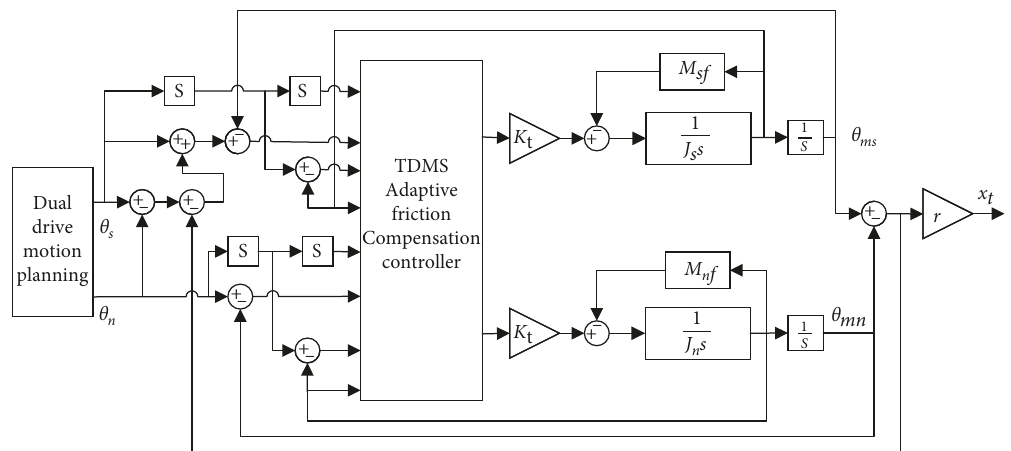
Figure 4: Control block diagram of two-axis differential microfeed system.